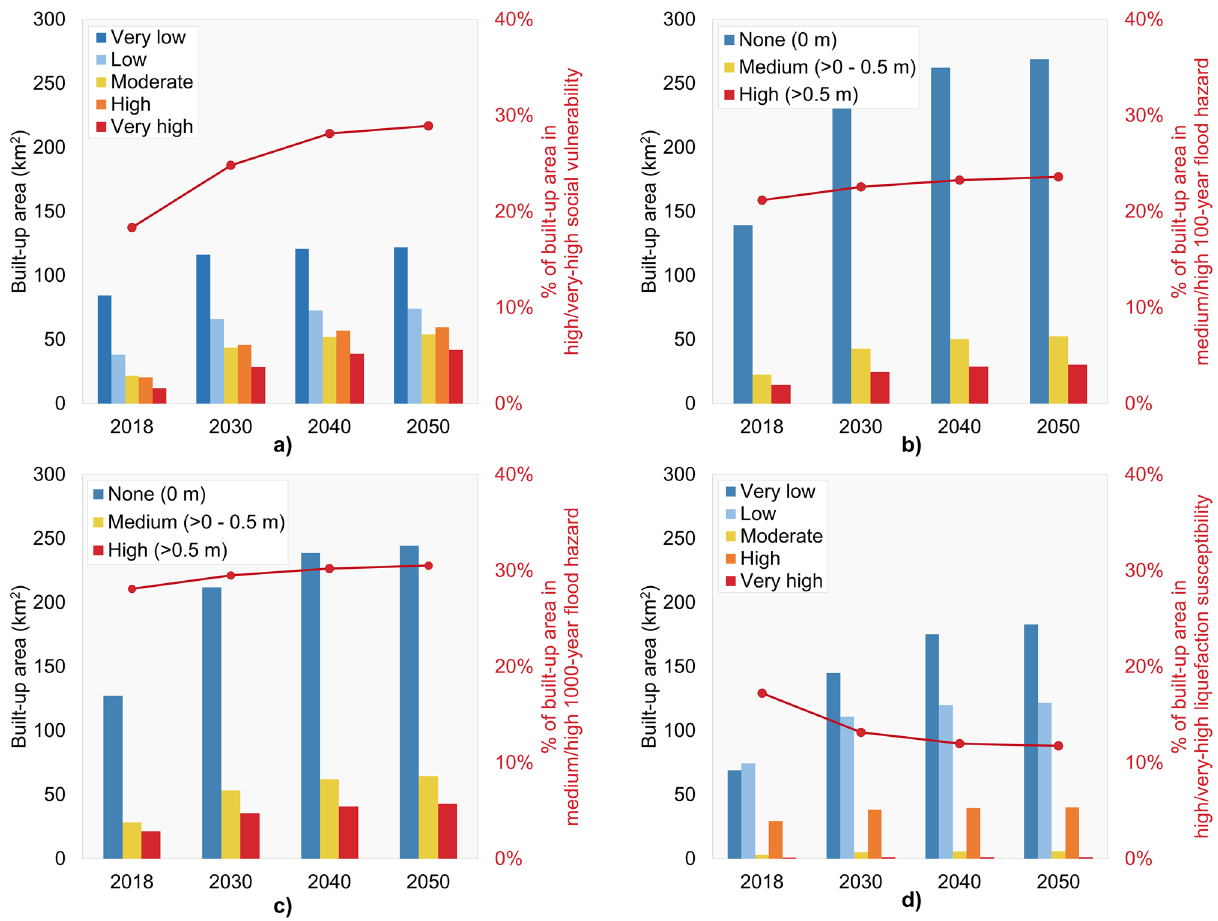
Figure 8. Evolution in built-up areas disaggregated by ( a ) SoVI category; ( b ) 100-year flood hazard depth range; ( c ) 1000-year flood hazard depth range; and ( d ) Liquefaction susceptibility